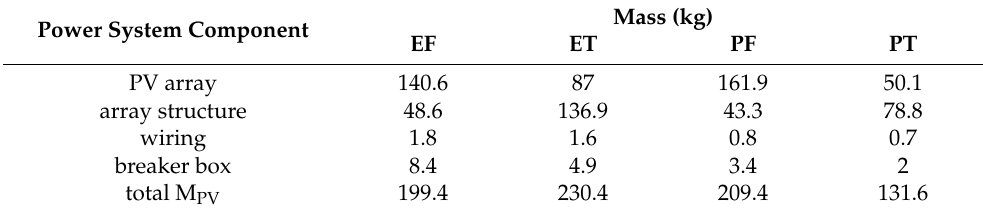
Table 20. PV+Li-S power system solar array mass breakdown.